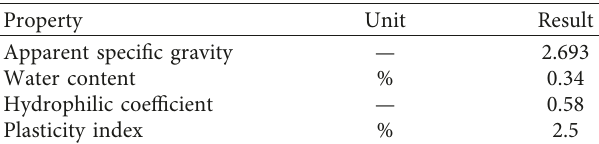
Table 5: Properties of mineral filler.